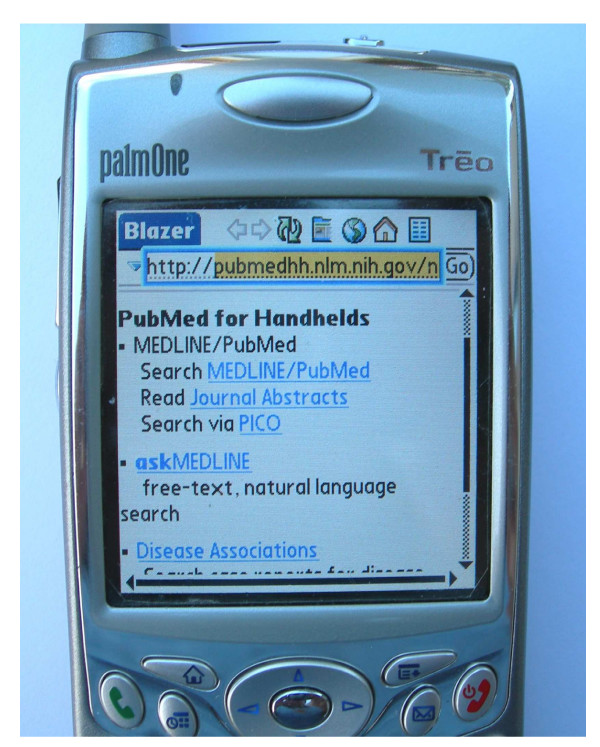
Index page of "PubMed for Handhelds" on the Palm Treo650 screen.